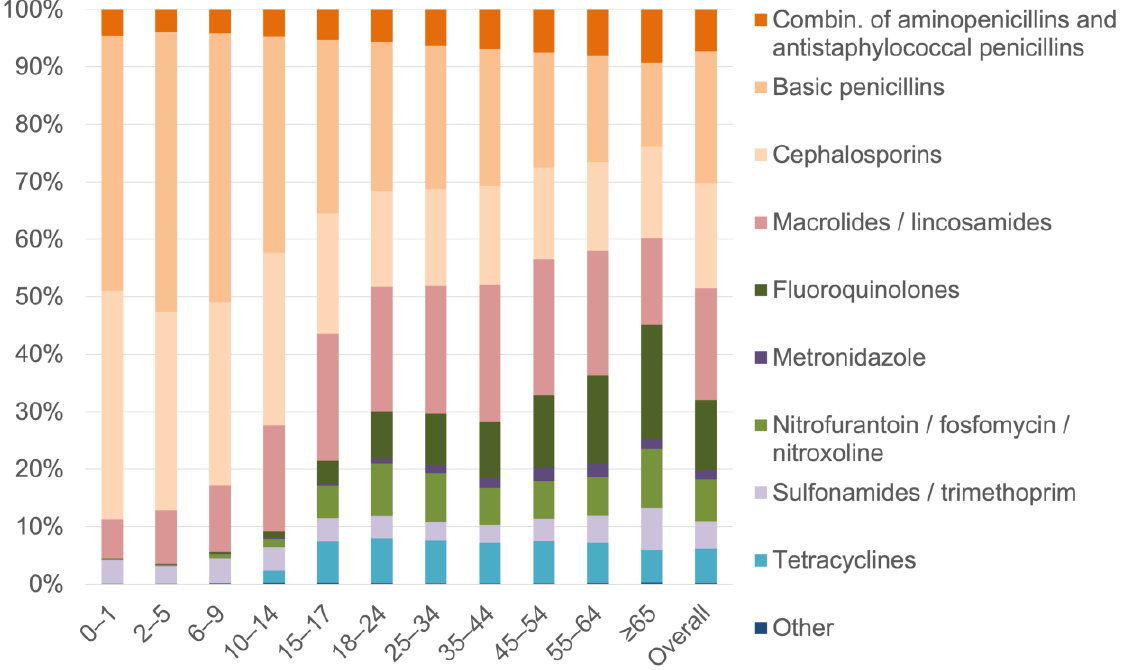
Figure 1. Proportional distribution of antibiotic prescriptions by antibiotic subgroup in 2018.